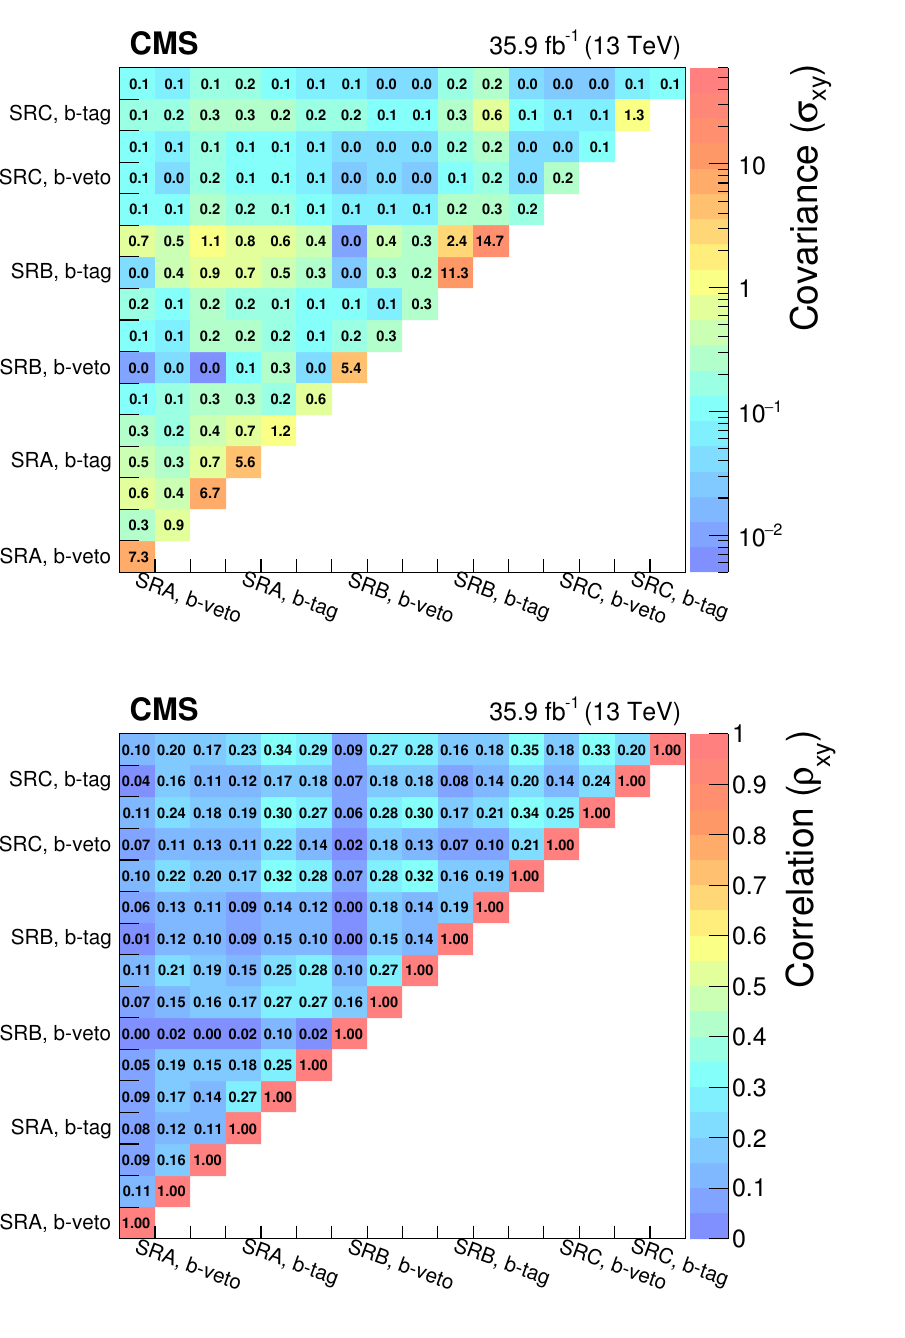
bins are shown in increasing T